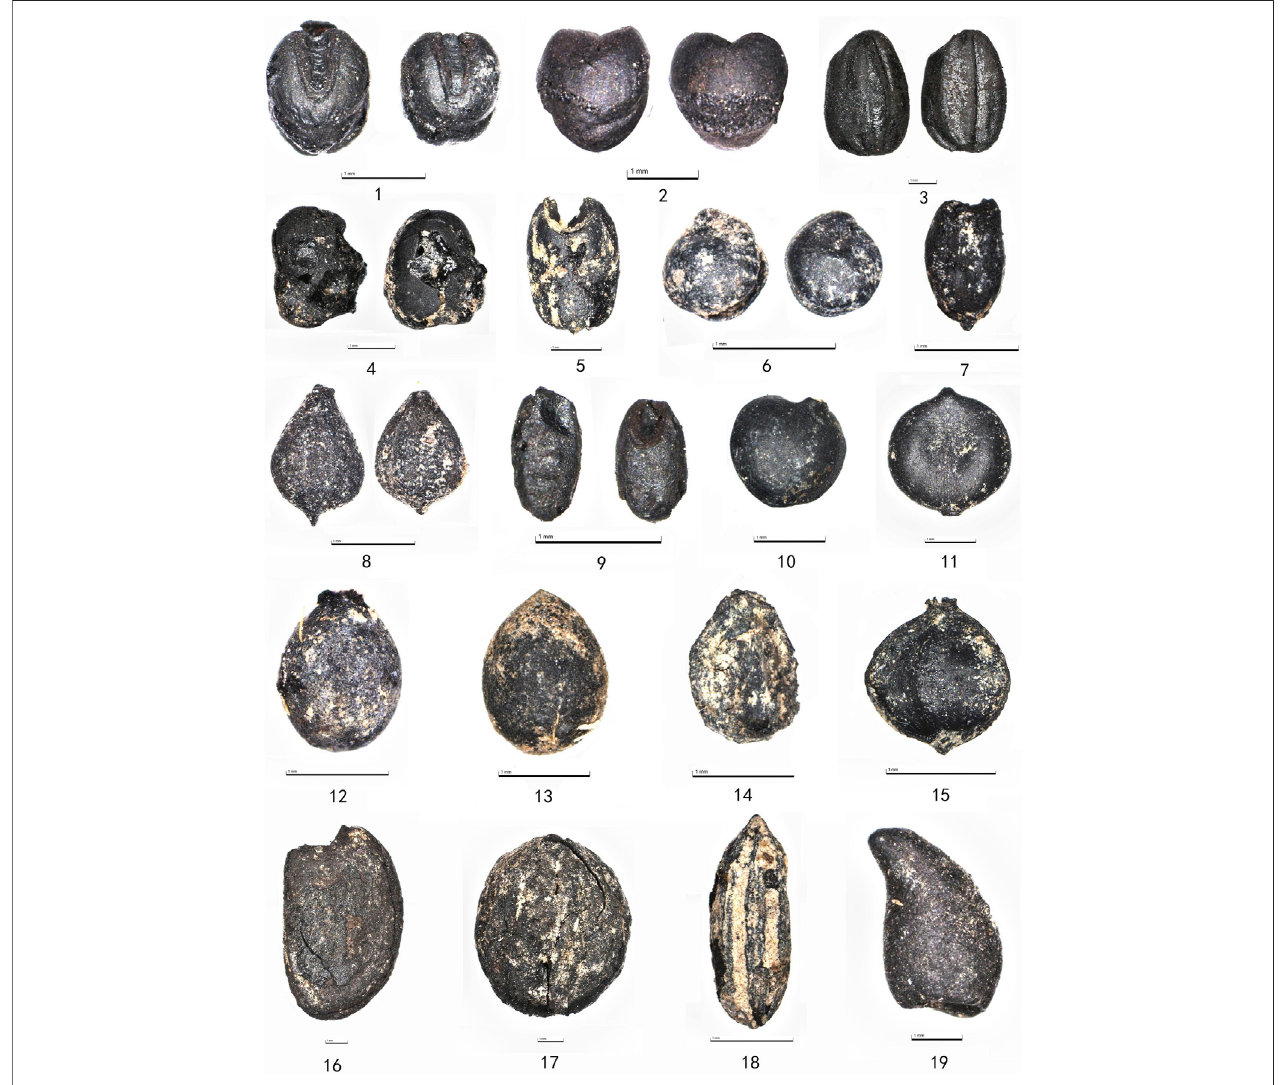
FIGURE 2 | Representative charred plant remains from the Suyang site: (1) Setaria italica, (2) Panicum miliaceum, (3) Oryza sativa, (4) Glycine max, (5) Triticum aestivum, (6) Chenopodium sp. , (7) Setaria sp. , (8) Scirpus Validus, (9) Digitaria sp. , (10) Corydalis sp., (11) Polygonum lapathifolium, (12) Acalypha australis, (13) Perilla sp. , (14) Patrinia villosa, (15) Scirpus juncoides, (16) Diospyros sp. , (17) Ziziphus sp. , (18) Cryptotaenia japonica, (19) Chaenomeles sp.